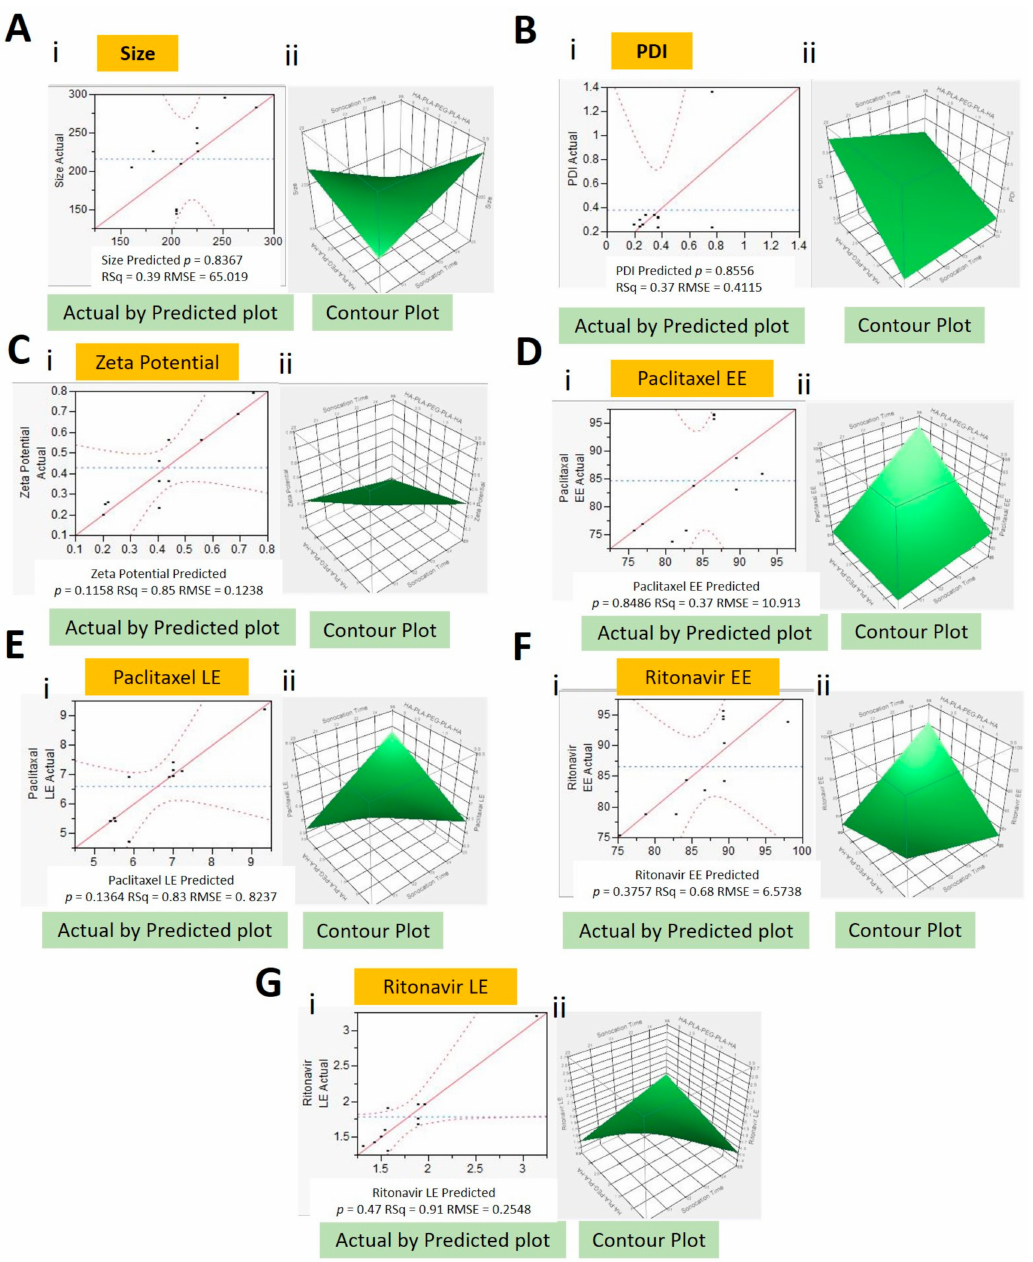
Figure 3. Actual by Predicted plots (i) and contour plots (ii) for dependent variables: Size ( A ), PDI ( B ), zeta potential ( C ), PTX entrapment efficiency (EE) ( D ), PTX loading efficiency (LE) ( E ), RTV EE ( F ), and RTV LE ( G